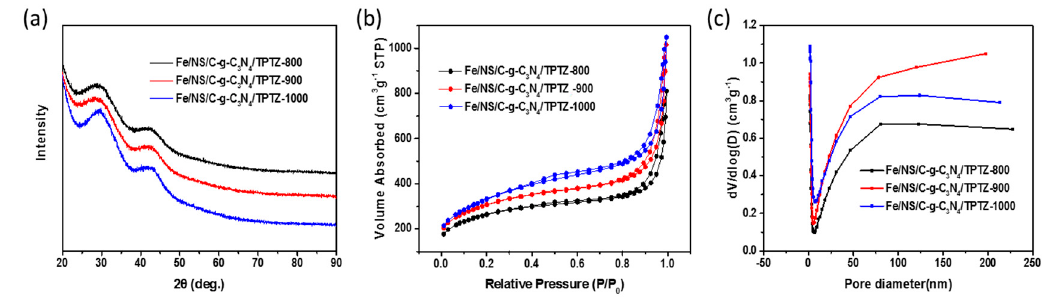
Figure 5. ( a ) XRD patterns; ( b ) N 2 adsorption ‐ desorption isotherms; and ( c ) corresponding pore